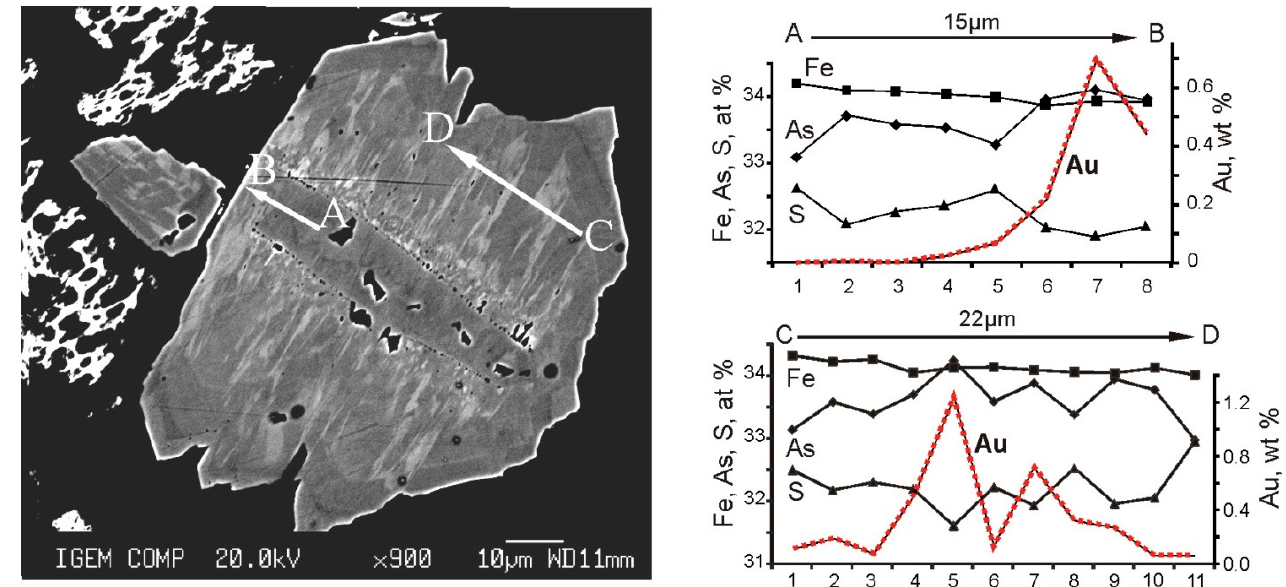
Figure 8. Variations of Fe, As, S (at%) and Au (wt%) in Apy-2, EPMA. Left —BSE image with an indication of the profiles A–B and C–D used to measure the composition of arsenopyrite. Note that profile A–B starts in Apy-2, replaced the relict Au-poor Apy-1, and finished in Au-rich Apy-2.